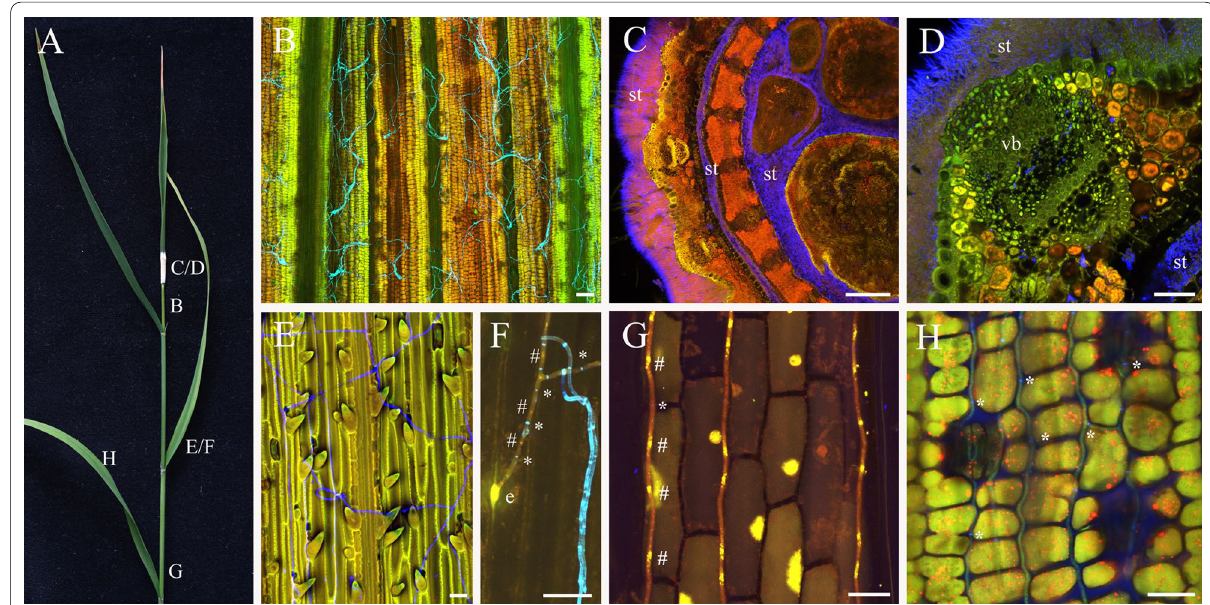
Fig. 3 Photograph and confocal laser scanning micrographs of Epichloë scottii – Melica uniflora association. a Photograph of E. scottii stroma bearing reproductive tiller of M. uniflora . Letters indicate the leaf parts, where samples were taken for CLS microscopy. b–h confocal laser scanning micrographs. Samples were treated with aniline blue diammonium salt to stain fungal and plant cell wall β-glucans (overlay of stain and autofluorescence of cytoplasm depicted in yellow, orange pseudo colors) and wheat germ agglutinin-Alexa Fluor 488 (WGA-AF488) to stain fungal chitin (blue pseudo color) and with propidium iodide ( f , g , only) to stain plant and fungal nuclei (yellow pseudo color). ( b ) epibiotic hyphae of E. scottii on the surface of the stem 2 cm below the base of stroma, maximum projection of 150 µm z-stack. ( c ) transverse section of unfertilized stroma tissue (st), maximum projection of 35 µm z-stack. d Higher magnification of ( c ) showing densely colonized vascular bundle (vb) and hyper-proliferative hyphal growth on the cuticle. e epibiotic hyphae of E. scottii on the leaf sheath. f epibiotic hyphae at point of exit of endobiotic hypha (e expressorium), maximum projection of 9.4 µm z-stack. Only after several hyphal compartments are formed, chitin can be visualized = by staining with WGA-AF488, depicted in blue pseudo color. g endobiotic hyphae of E. scottii in leaf sheath epidermis, maximum projection of 144 µm z-stack. h endobiotic hyphae of E. scottii in leaf blade, the channel for blue pseudocolor is overexposed to visualize chitin in septa of endobiotic hyphae, maximum projection of 12 µm z-stack. Septa in F, G, and H are marked with asterisks (*) and nuclei in ( f ) and ( g ) with hashes (#). Bars 20 µm ( e – h ), 50 µm ( b , d ) 200 µm ( c =